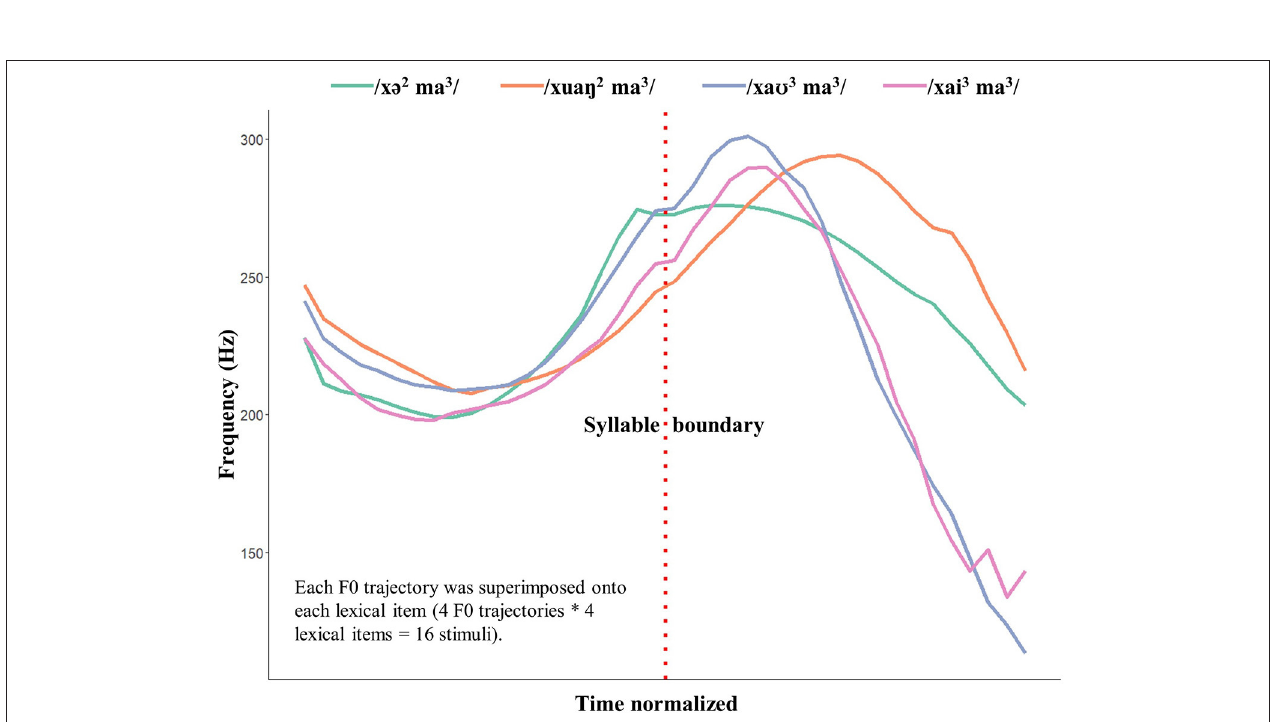
FIGURE 2 | F0 trajectories of the base tokens (duration normalized). Each of the four F0 trajectories is superimposed onto each duration-normalized base token, leading to the 16 stimuli used in our study (4 lexical items * 4 F0 trajectories).